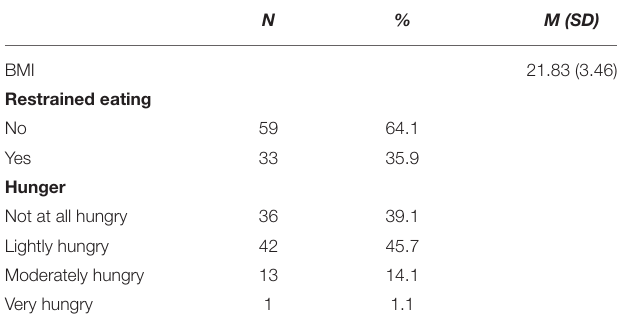
TABLE 3 | Descriptive statistics of the confounding